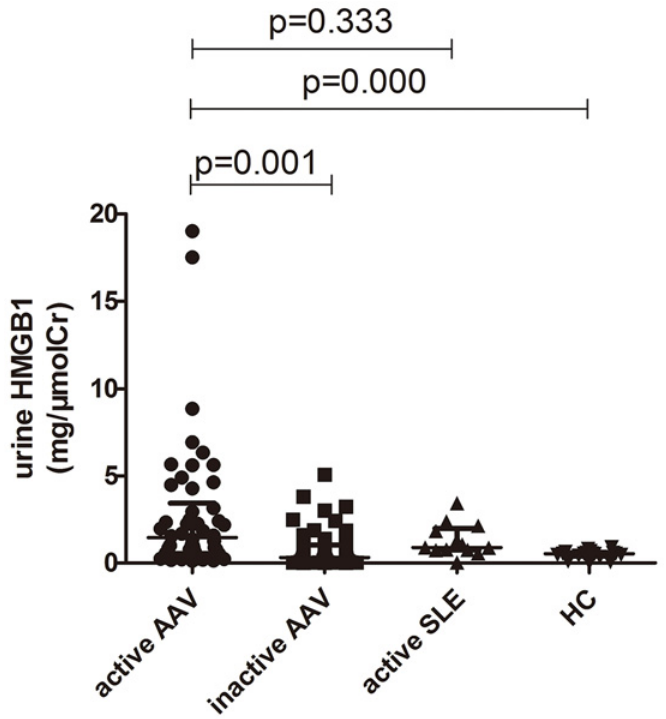
doi:10.1371/journal.pone.0123586.g001